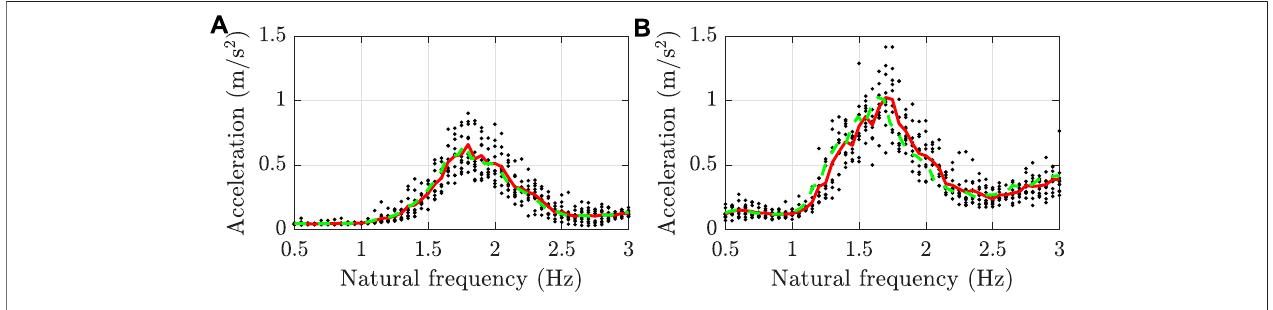
FIGURE 11 | Maximum RMS accelerations caused by (A) 100 and (B) 350 pedestrians for different footbridge natural frequencies: results for each of the 10 analyses (black dots) and mean values (red line). Green dotted line: mean accelerations obtained accounting for the added pedestrian mass.